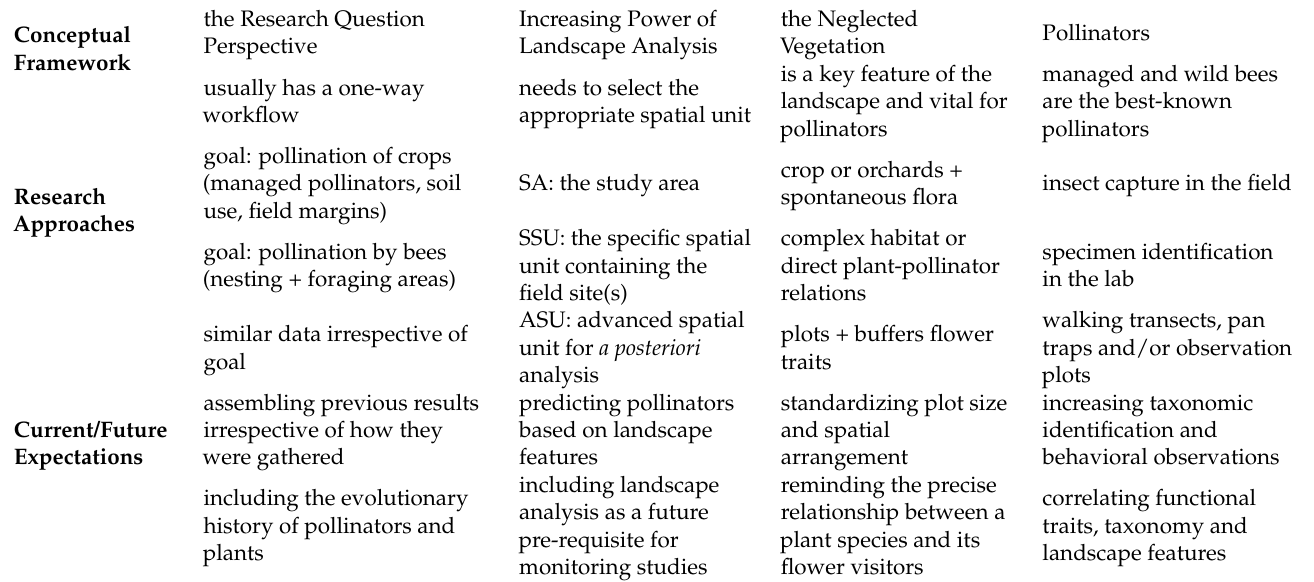
Table 1. Monitoring approaches. The main components of the present conceptual